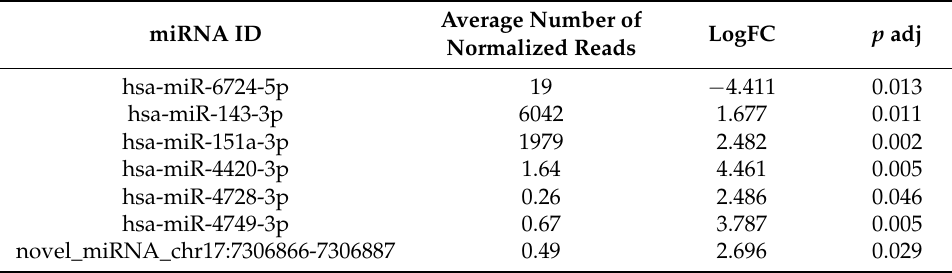
Table 1. miRNAs differentially expressed in AYA T-ALL vs. pediatric T-ALL. Average Number of miRNA ID LogFC p adj Normalized Reads hsa-miR-6724-5p 19 − 4.411 0.013 hsa-miR-143-3p 6042 1.677